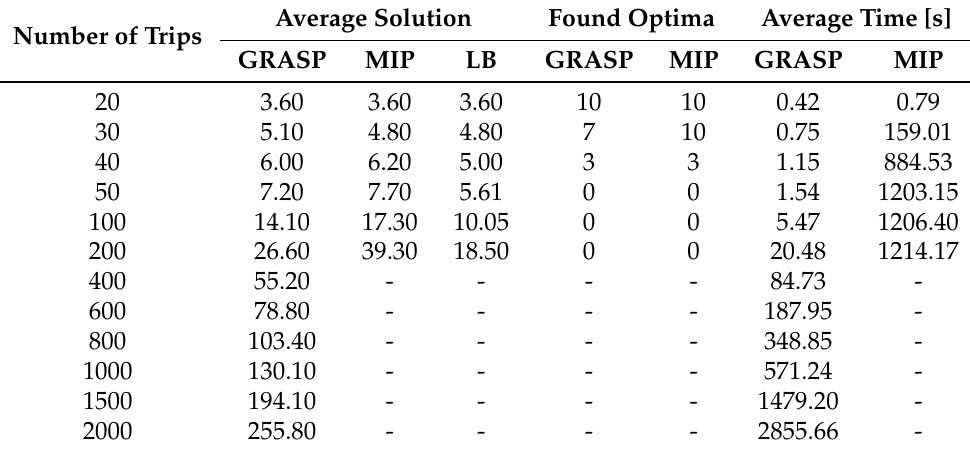
Table 2. Comparison of the proposed GRASP and MIP for synthetic problem instances of different